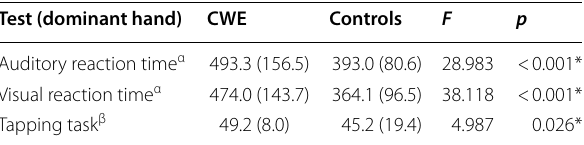
Table 2 Psychomotor performance of children with epilepsy and controls